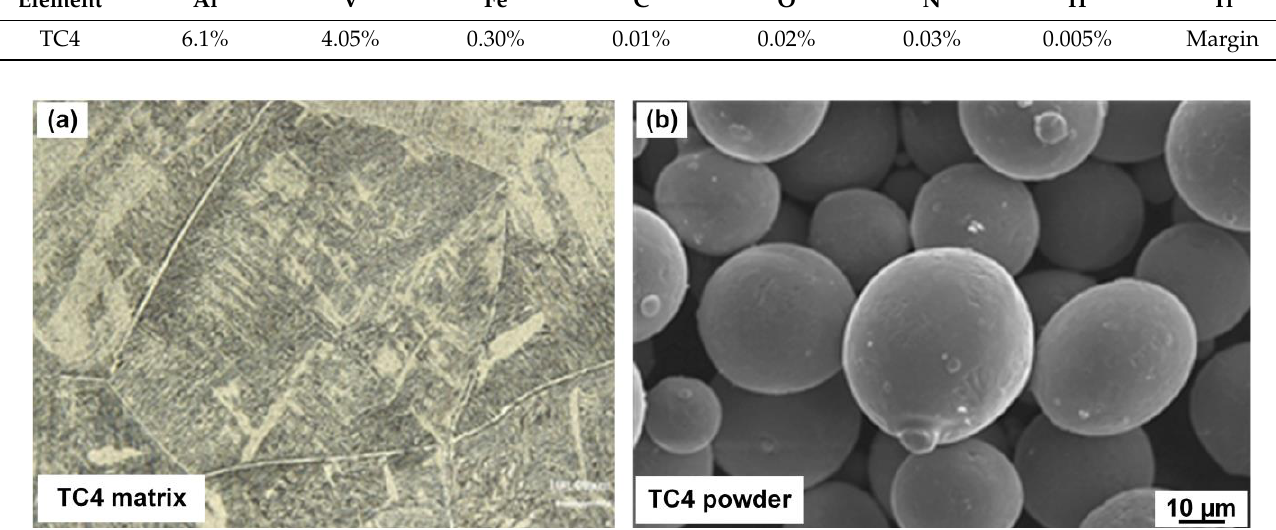
Figure 1. Microstructure for TC4 matrix and repairing powder: ( a ) TC4 matrix, ( b ) TC4 powder.